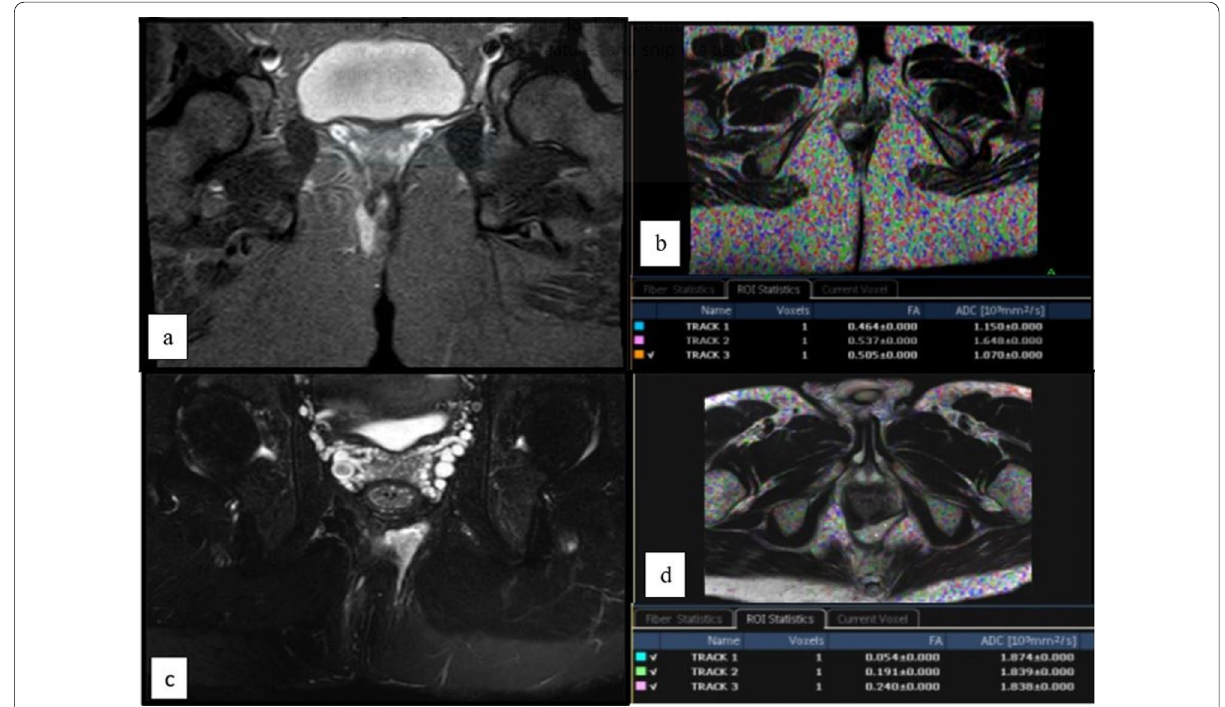
Fig. 6 a Coronal STIR WI, b axial DTI/T2 fused images with ROI (FA and ADC) placed in the trans-sphincteric showing high track FA (0.505) and ADC values (1.070) indicating inactive condition with c coronal STIR WI, d axial DTI/T2 fused images with ROI (FA and ADC) placed in the saddle trans-sphincteric track from 4 to 7 O’clock showing low track FA (0.191) and ADC values (1.839) indicating active